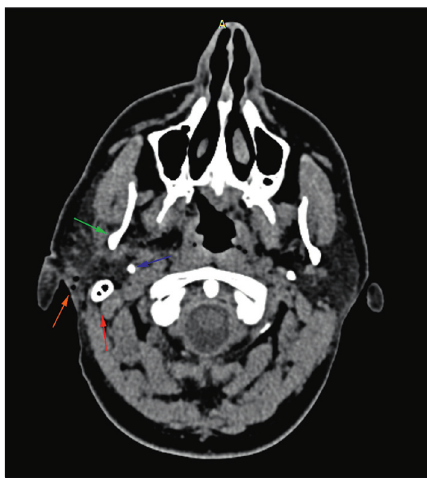
Figure 3: CT scan showing a mastoid tip (red arrow), styloid process (blue arrow), ramus of the mandible (green arrow), and entry trajectory (orange